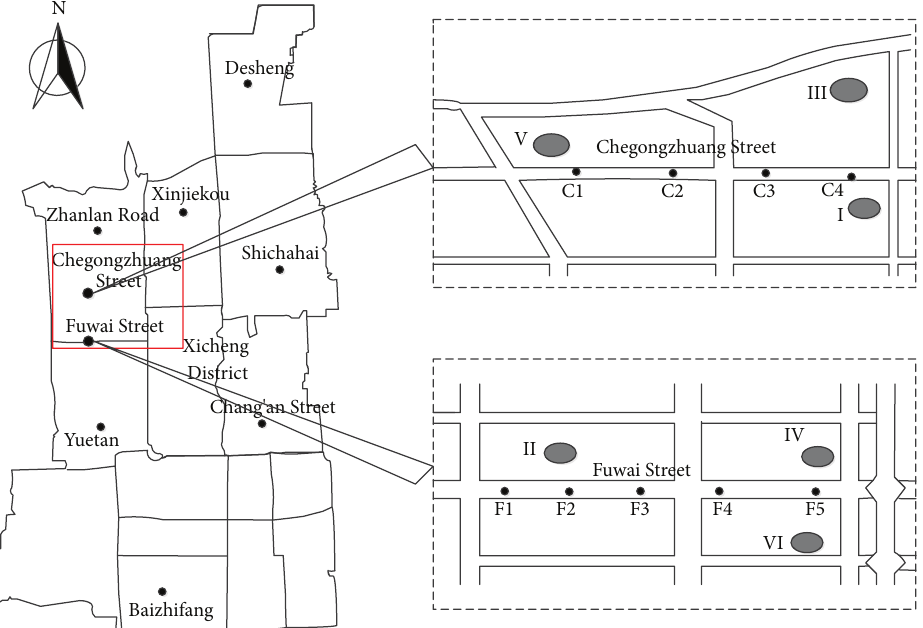
Figure 1: Sampling sites in Xicheng District of Beijing, China. Note: black spots represent functional areas including old residential area (I), comprehensive area (II), new residential area (III), pedestrian only commercial area (IV), educational area (V), and business area (VI). Heavy traffic area at Chegongzhuang Street (C1 to C4) and Fuwai Street (F1 to